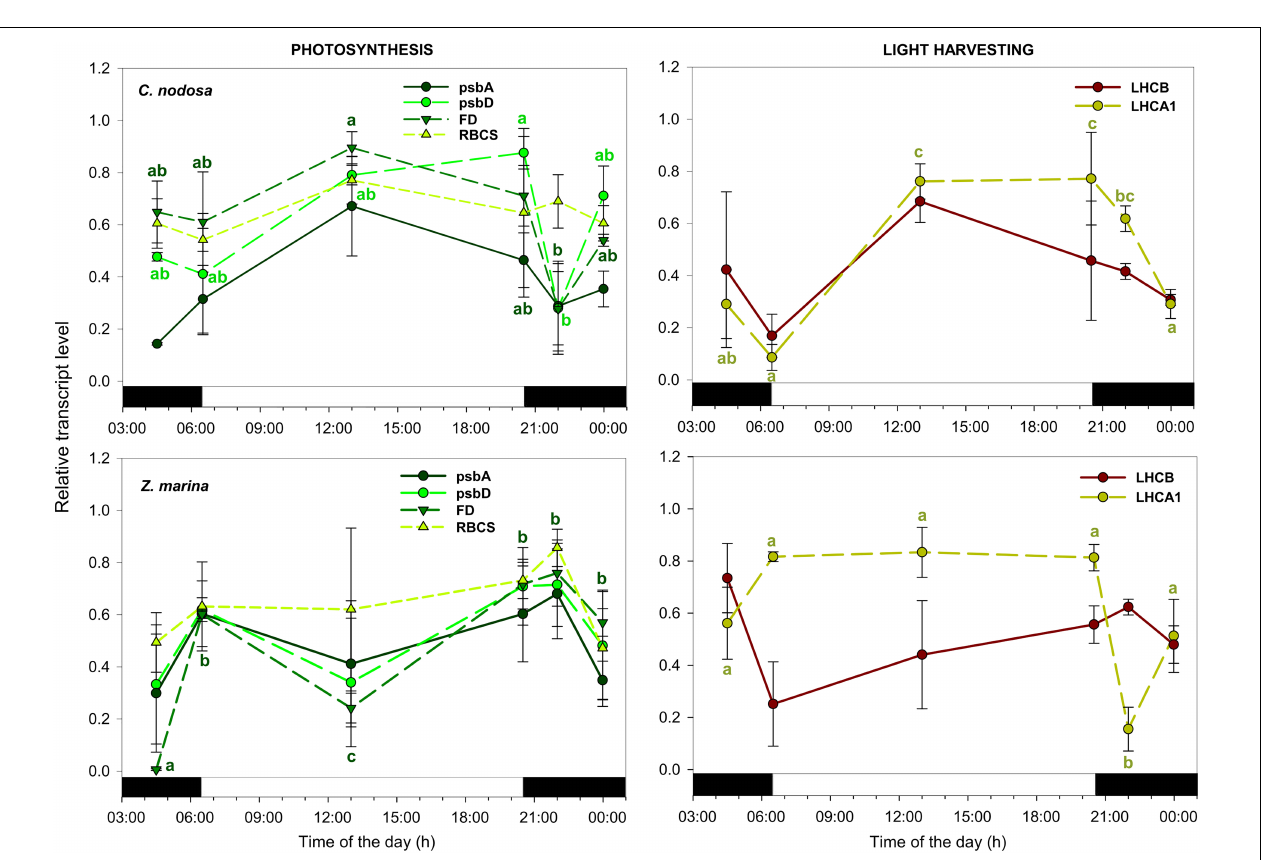
FIGURE 2 | Daily transcript levels (as normalized – (cid:49) CT data) of Genes of Interests (GOIs) with a function in photosynthesis and light harvesting in C. nodosa (upper panels) and Z. marina (lower panels). Significant daily changes ( P < 0.05) for each GOI based on SNK tests following one-way ANOVAs ( Tables 3 , 4 ), are indicated with different letters. Letters are coloured as the respective GOI. Values are mean ± SE for n = 3.